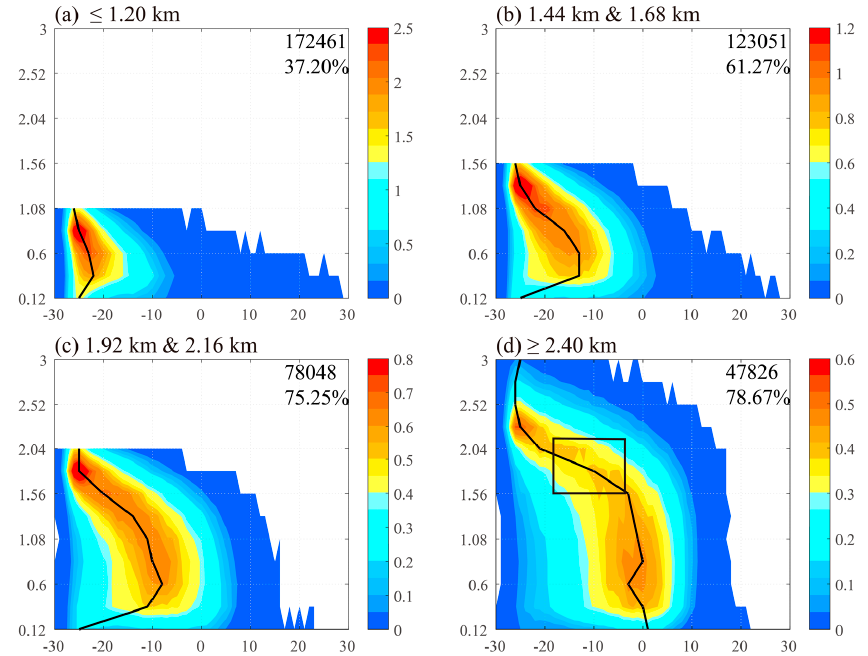
Figure 7. Contoured frequency by relative height (height above cloud base) diagrams (CFRHDs) of radar reflectivity of Sc clouds normalized by the total numbers of samples. The solid black lines connect the points at different heights with the maximum frequencies. According to cloud thickness, CFRHDs are categorized into four groups: Sc tk ≤ 1.20 km ( a ); Sc tk = 1.44 and 1.68 km ( b ); Sc tk = 1.92 and 2.16 km ( c ); Sc tk ≥ 2.40 km ( d ). The Sc clouds layers sample number and cloud precipitation frequency in each thickness categories are marked in the upper-right corner of the figures. The unit of color shading is % · dBZ − 1 . The vertical coordinate-axis Y in figure is the height (km) above cloud